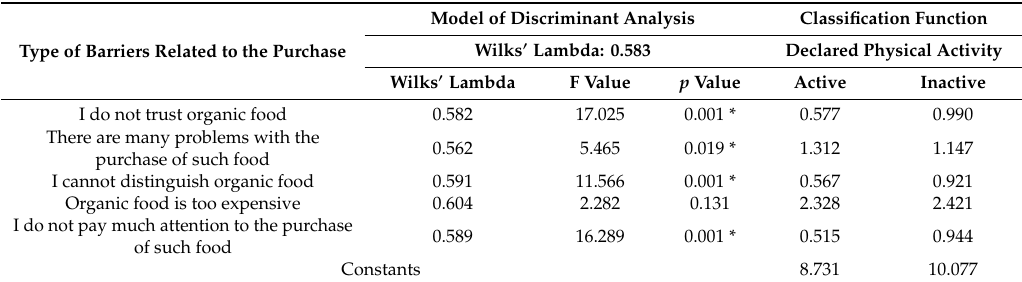
Table 3. Barriers a ff ecting the purchase of organic